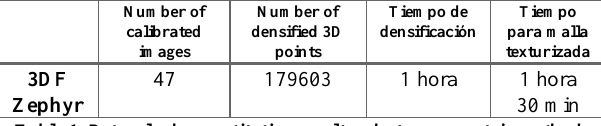
Table 1. Petroglyph quantitative results, photogrammetric method.